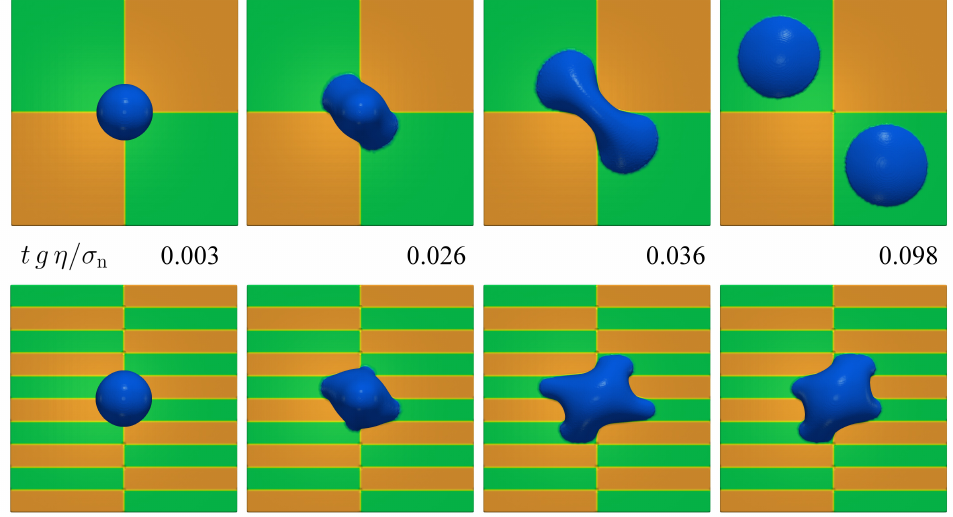
Figure 25. Wetting behavior of a droplet on substrates composed of hydrophilic regions (green, θ = 45°) and hydrophobic regions (orange, θ =